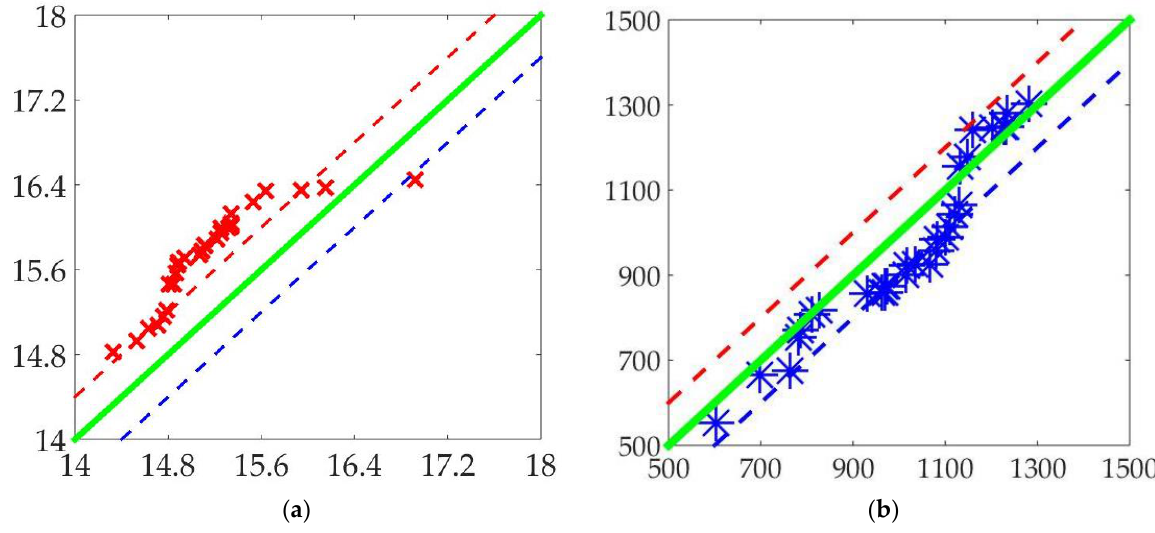
Figure 4. ( a ) Trends of annual temperature. ( b ) Trends of annual precipitation. The cumulative upward trend of air temperature could be the outcome of global warming, which is due to the “built - up heat island”, greenhouse influence, and long-standing climate inconsistency [6 – 9]. In the present study, the temperature during the summer season was higher. Similarly, Gu et al. [43]. found a higher magnitude of air temperature with an increasing trend in the summer seasons, which was superior to the other periods (Figure 5).